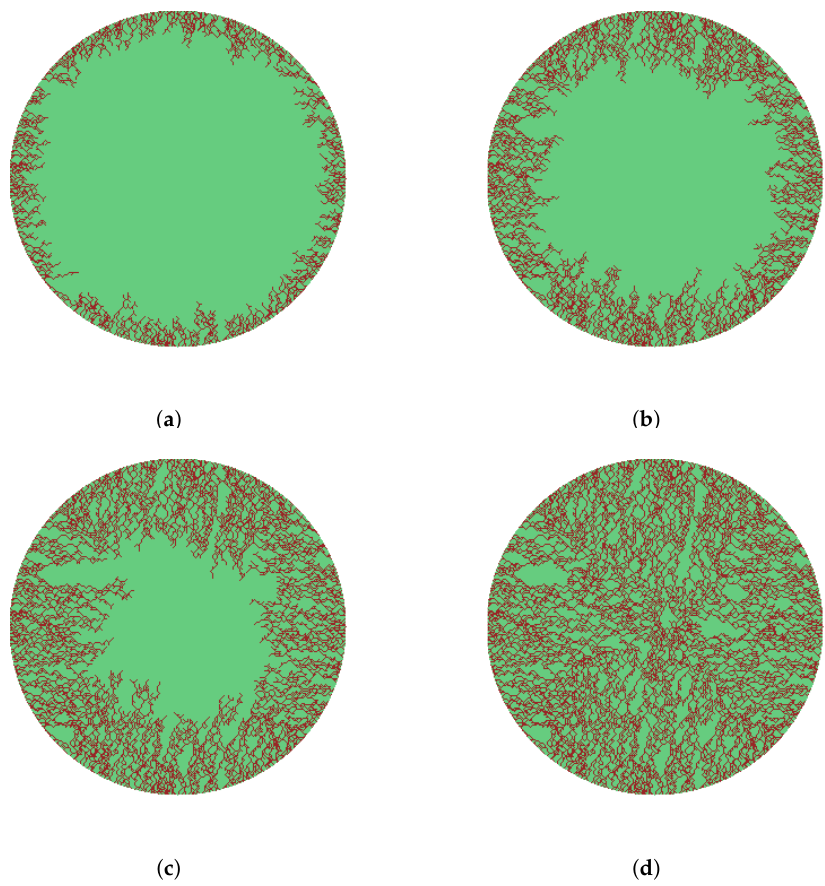
Figure 7. Eden model simulation of angiogenesis for a circular skin wound. is wound space and is vasculature growth. Different growth stages of the onset and progression of capillary tips, sprouts, and blocks, showing wound contraction and leading closure, are given in ( a – d ), representing 25%, 50%, 75%, and 100% vascularization, respectively. The capillary growth rate is 1 step and the branching length is 2